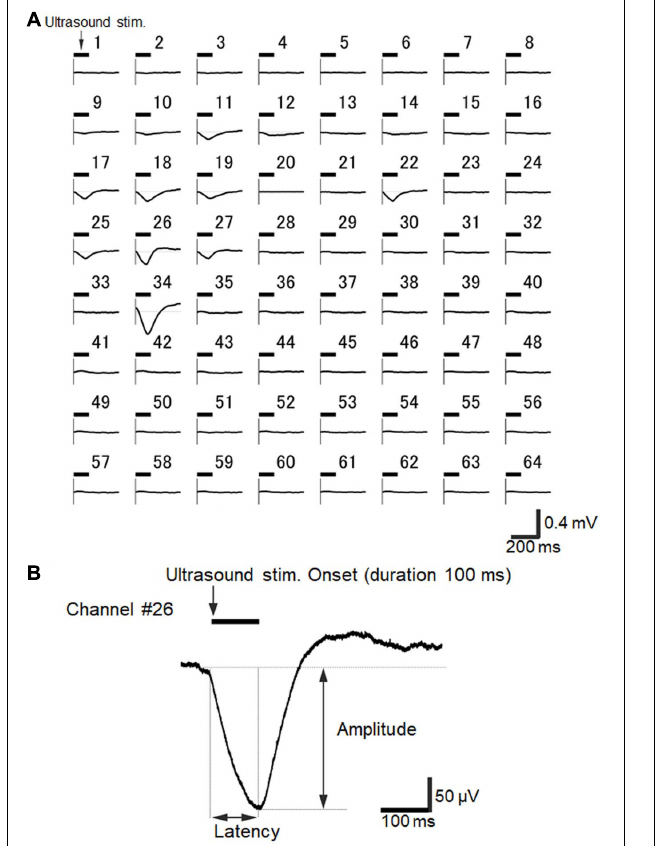
FIGURE 8 | Ultrasound-driven LFP responses recorded over the 64 electrodes of the MEA probe. (A) A typical example of spatiotemporal ultrasound-driven responses, where the ultrasound stimulation was delivered to the same slice shown in Figure 6 . The stimulation pressure of the transducer was 210 kPa, and the stimulation duration was 100 ms. The timing of the ultrasound stimulation is illustrated by a horizontal bar on the upper left side of each plot of individual LFP responses for recorded electrodes. Each average waveform was obtained over 5 trials. (B) Typical LFP response waveform recorded at Ch 26 in response to the same ultrasound stimulation. The LFP response trace is the same as shown in A. The average waveform was obtained over 10 trials. Response amplitude and latency are also indicated in the plot.